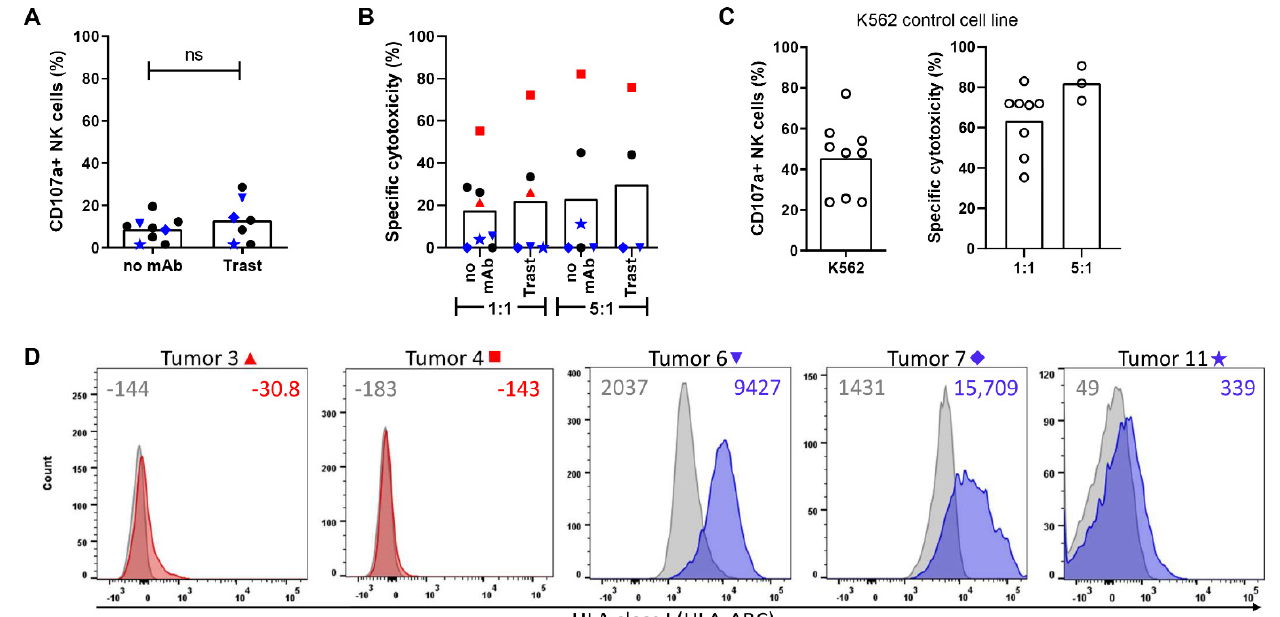
Figure 3. NK cell degranulation and cytotoxic potential against HER2 non-amplified primary breast cancer. ( A , B ) Patient- derived breast cancer cells were dissociated to single cells and incubated with or without trastuzumab for 30 min and subsequently co-cultured with IL-2-activated NK cells in 1:1 or 5:1 E:T ratios for 16 h at 21% O 2 and analyzed by flow cytometry. ( A ) Degranulating NK cells are shown as percentage CD107a + NK cells, and each symbol (black and blue) represents one tumor sample; the blue symbols correspond to the colors of the histograms in ( D ). ( B ) Dead tumor cells are shown as specific cytotoxicity. The bar graphs indicate the mean, while each dot represents an individual breast cancer specimen. The red and blue symbols correspond to the histograms in ( D ). ( C ) K562 cells were included as a control in CD107a and cytotoxicity assays to show that NK cells were potent killers. ( D ) Histograms show HLA class I staining of breast cancer cells (red for samples with kill, blue for samples with low kill), and grey histograms show isotype controls. Tumors 3 and 4 (red symbols) were not available for CD107a assays in A. Median fluorescent intensity is depicted for each staining. ns = not significant.